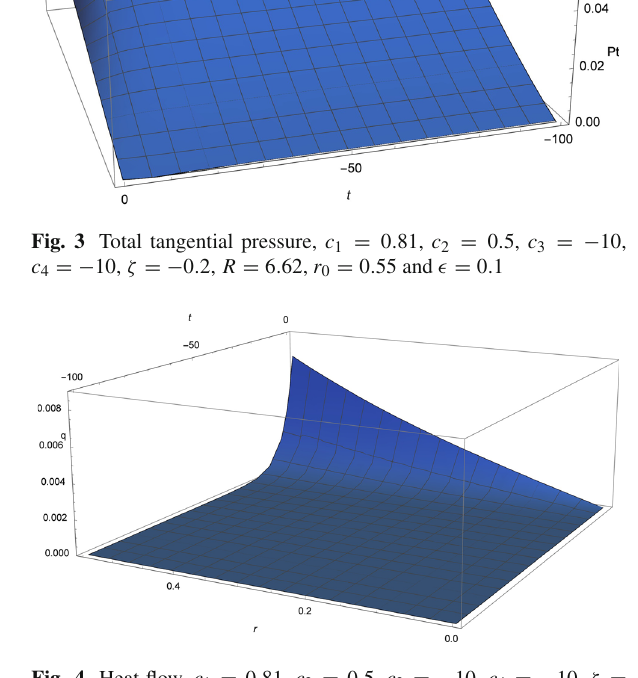
Fig. 4 Heat flow, c 1 = 0 . 81, c 2 = 0 . 5, c 3 = − 10, c 4 = − 10, ζ = − 0 . 2, R = 6 . 62, r = 0 . 55 and (cid:7) = 0 . 0